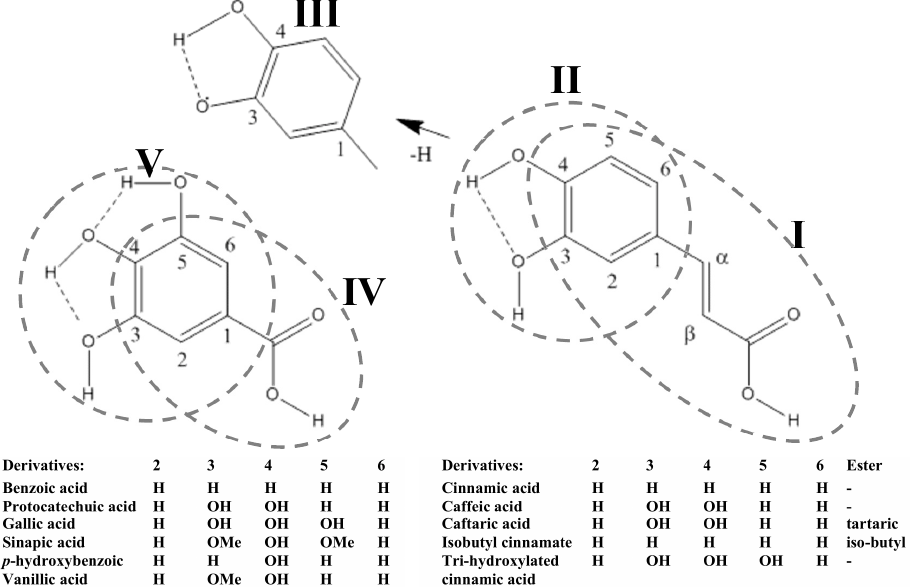
Figure 2. Representative structures for phenolic acids: ( I ) cinnamic moiety; ( II ) catechol moiety; ( III ) radical formed by catechol; ( IV ) benzoic acid moiety; ( V ) pyrogallol moiety. Substitution patterns for some derivatives are included.